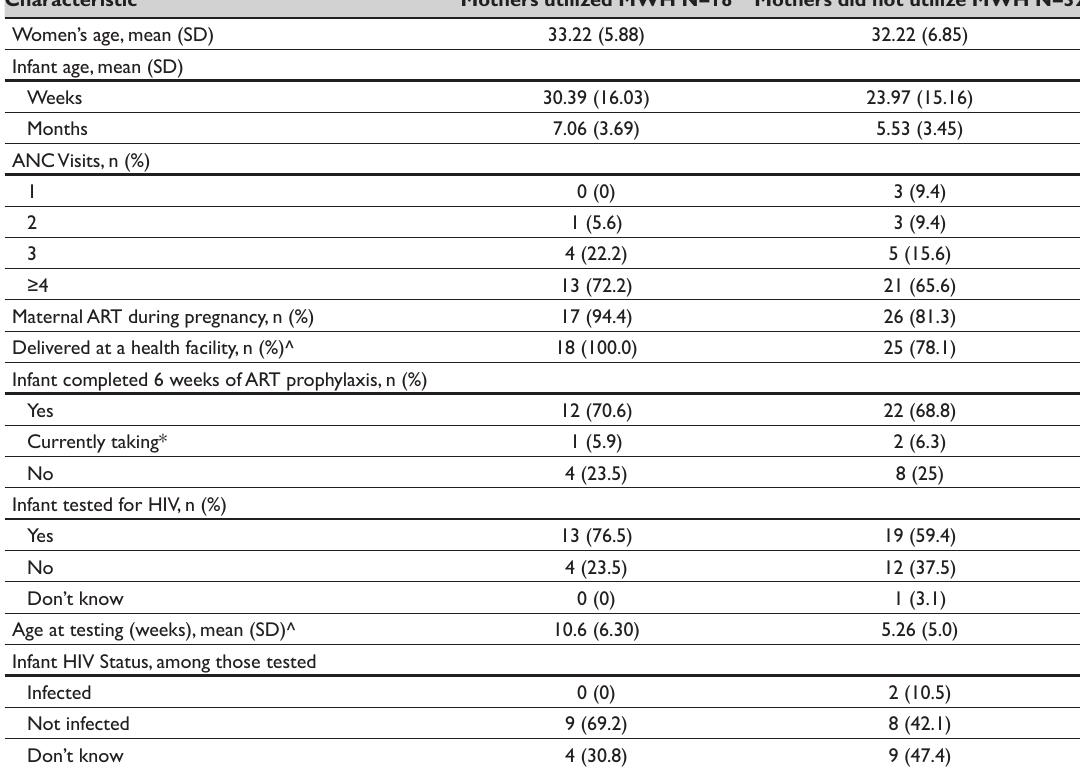
Table III: Characteristics of self-reported HIV-positive women and HIV-exposed infants stratified by utilization of a MWH